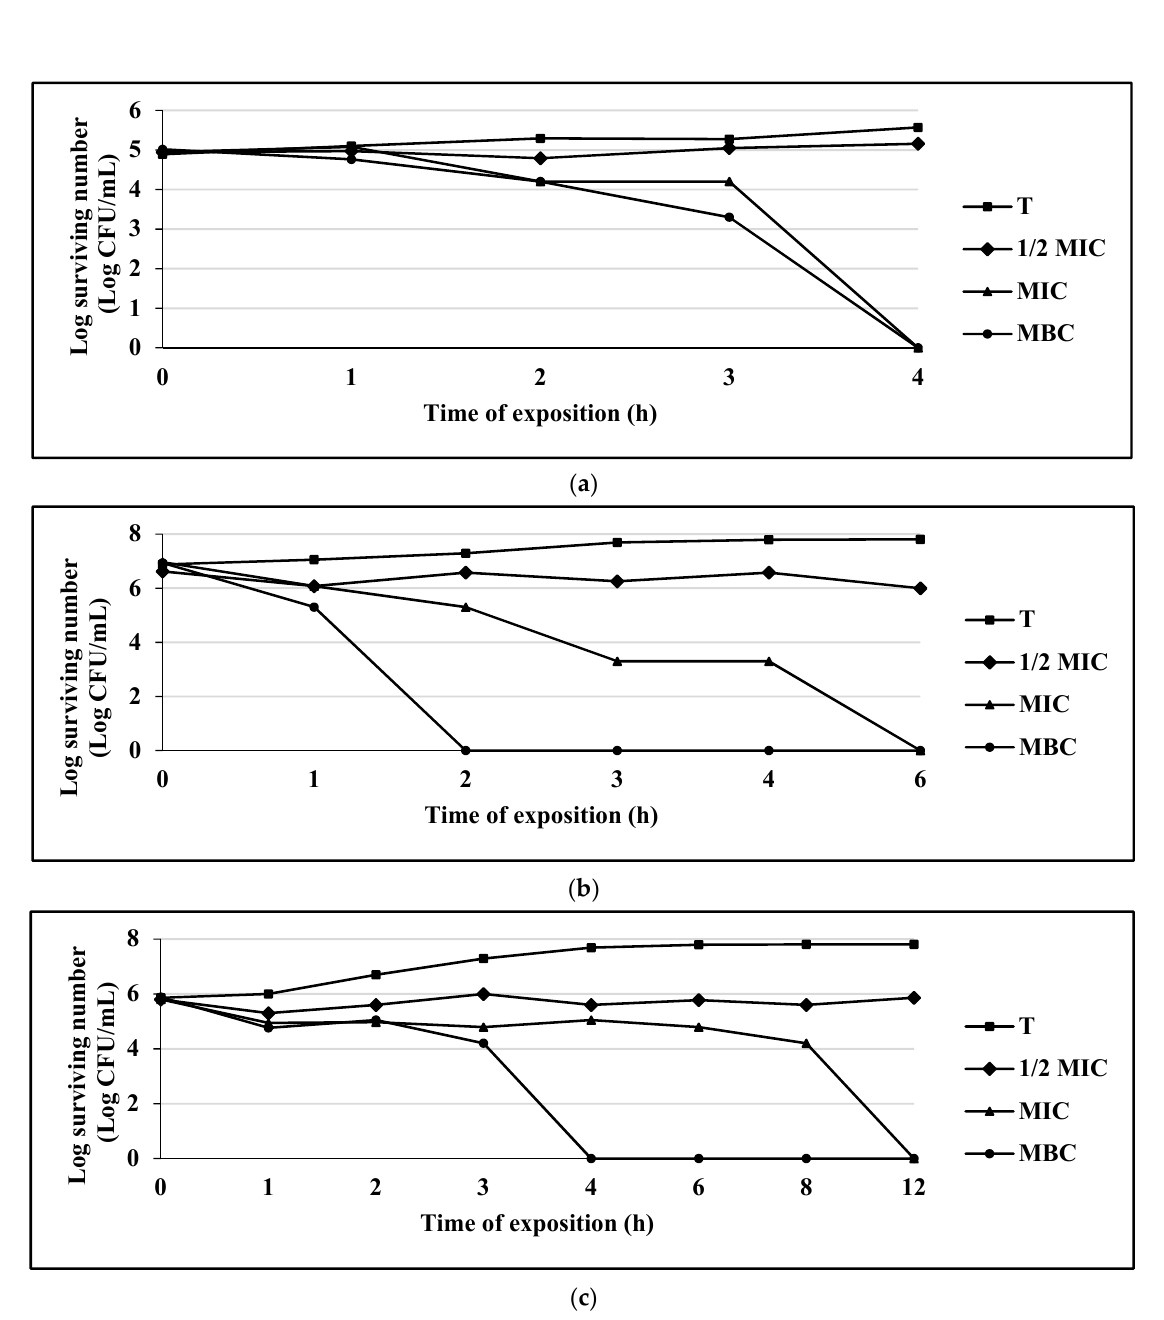
Figure 2. ( a ) Survival curve of E. coli exposed to carvacrol . Data are represented as the mean ± S.E. ( n = 3). The concentrations used were: 0.062 mg/mL (½ MIC), 0.125 mg/mL (MIC), and 0.25 mg/mL (MBC); the control group (T) only contains the bacterial culture. ( b ) Survival curve of S. aureus 75MR exposed to carvacrol . Data are represented as the mean ± S.E. ( n = 3). The concentrations used were: 0.062 mg/mL (½ MIC), 0.125 mg/mL (MIC), and 0.25 mg/mL (MBC); the control group (T) only contains the bacterial culture. ( c ) Survival curve of C. albicans CUSI exposed to carvacrol . Data are represented as the mean ± S.E. ( n = 3). The concentrations used were: 0.01 mg/mL (½ MIC), 0.03 mg/mL (MIC), and 0.062 mg/mL (MBC); the control group (T) only contains the bacterial culture.